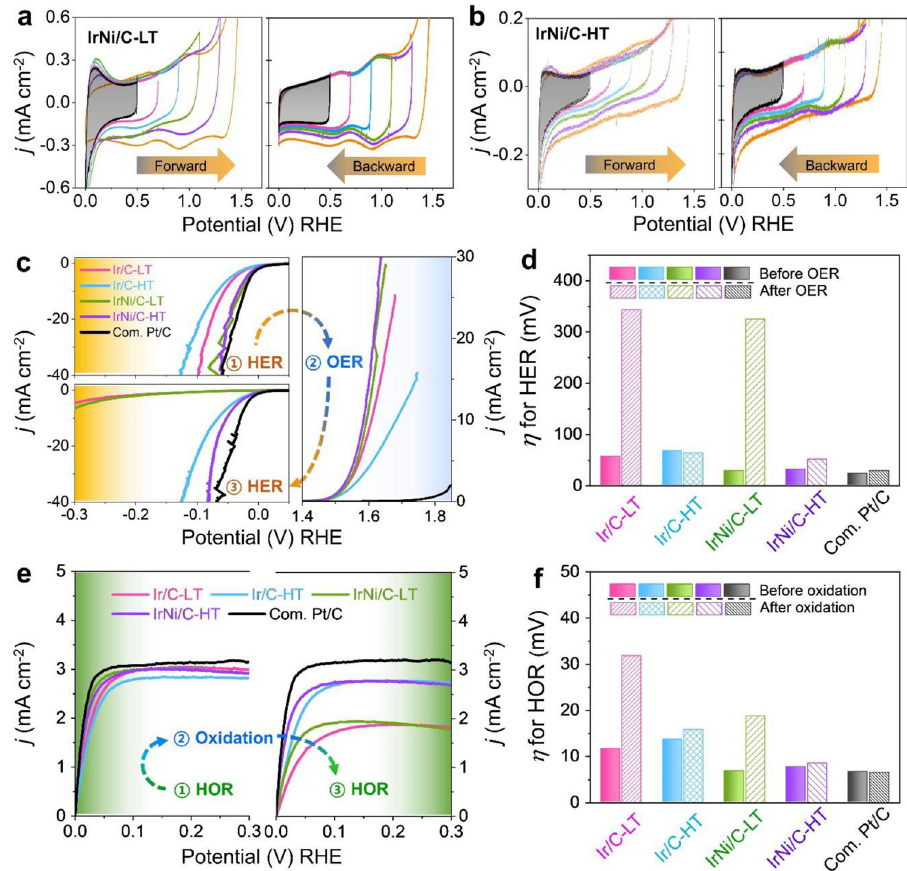
Fig. 2 Electrochemical properties and catalytic reversibility of the Ir-based electrocatalyst. Cyclic voltammetry (CV) of a IrNi/C-LT and b IrNi/C-HT catalyst recorded with 50 mV s – 1 in 0.05 M H 2 SO 4 solution. The lower potential limit (LPL) is constantly 0.05 V RHE . The upper potential limit was increased from 0.5 to 1.5 V and decreased from 1.5 to 0.5 V in 200-mV steps. c iR-corrected current-potential curves for hydrogen evolution reaction (HER), oxygen evolution reaction (OER), and HER after OER. d Comparison between trends in activities for HER and HER after the OER test, expressed as overpotentials required for 10 mA cm – 2 . e iR-corrected current-potential curves for hydrogen oxidation reaction (HOR) and HOR after oxidation. Oxidation was conducted via fi ve cycles of CV between 0.05 and 1.5 V. f Comparison between trends in activities for HOR and HOR after oxidation, expressed as overpotentials required for 1 mA cm – 2